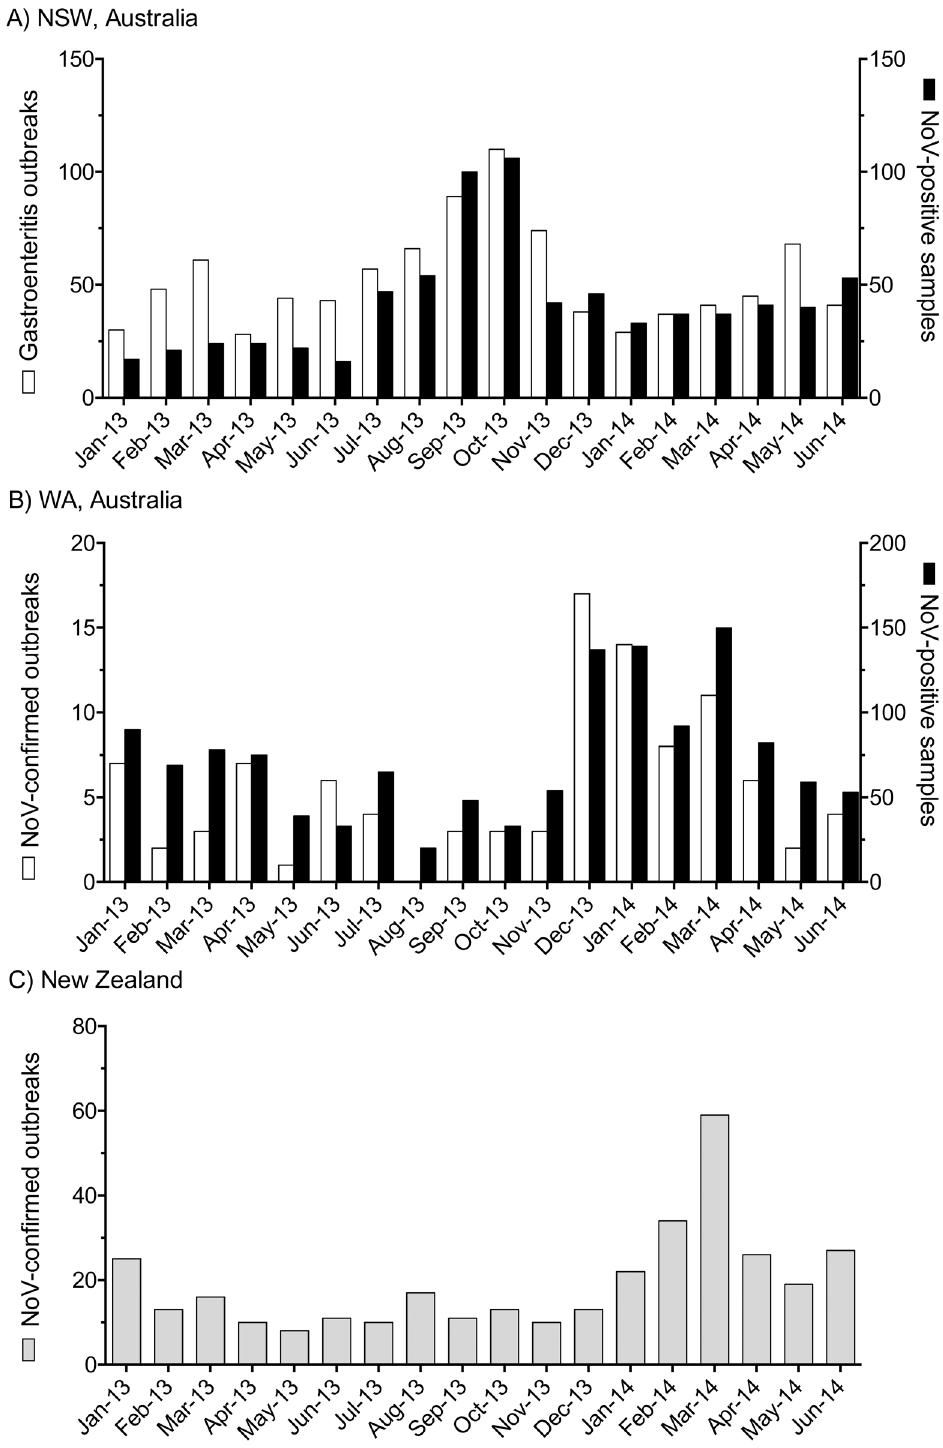
Fig 1. The incidence of NoV-associated gastroenteritis in NSW and WA, Australia and New Zealand from January 2013 to June 2014. (A) The number of monthly institutional gastroenteritis outbreaks reported to NSW Health (white) was compared to the monthly number of NoV-positive cases (black) reported to SEALS diagnostics laboratory Prince of Wales Hospital, NSW, Australia. (B) The number of confirmed NoV- outbreaks was compared by month to the number of NoV positive cases reported to PathWest